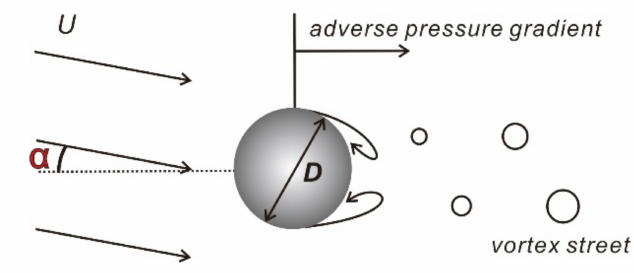
Figure 4. Schematic sketch of Von Karman’s vortex street and angle of